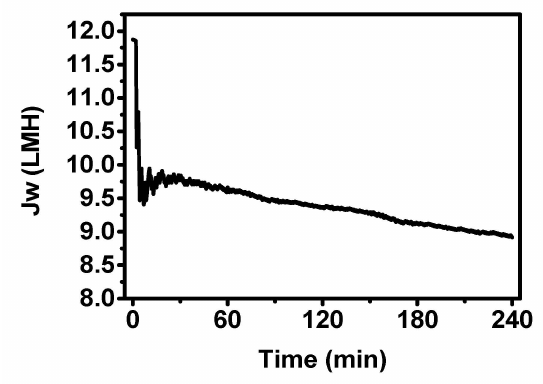
Figure 6. FO desalination with 0.3 g/mL STPH draw solution and simulated seawater (0.6M NaCl) as the feed